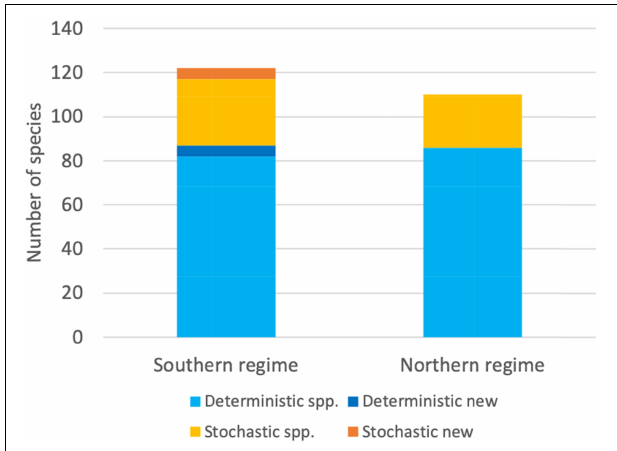
FIGURE 4 | Bar plots showing the number of deterministic (light blue color) and stochastic/rare (yellow) species in the southern and northern spatial regime. Shown are also the stochastic/rare species from the northern regime that became deterministic (“Deterministic new”; dark blue) and remained stochastic/rare (“Stochastic new”, orange) in the southern spatial regime.